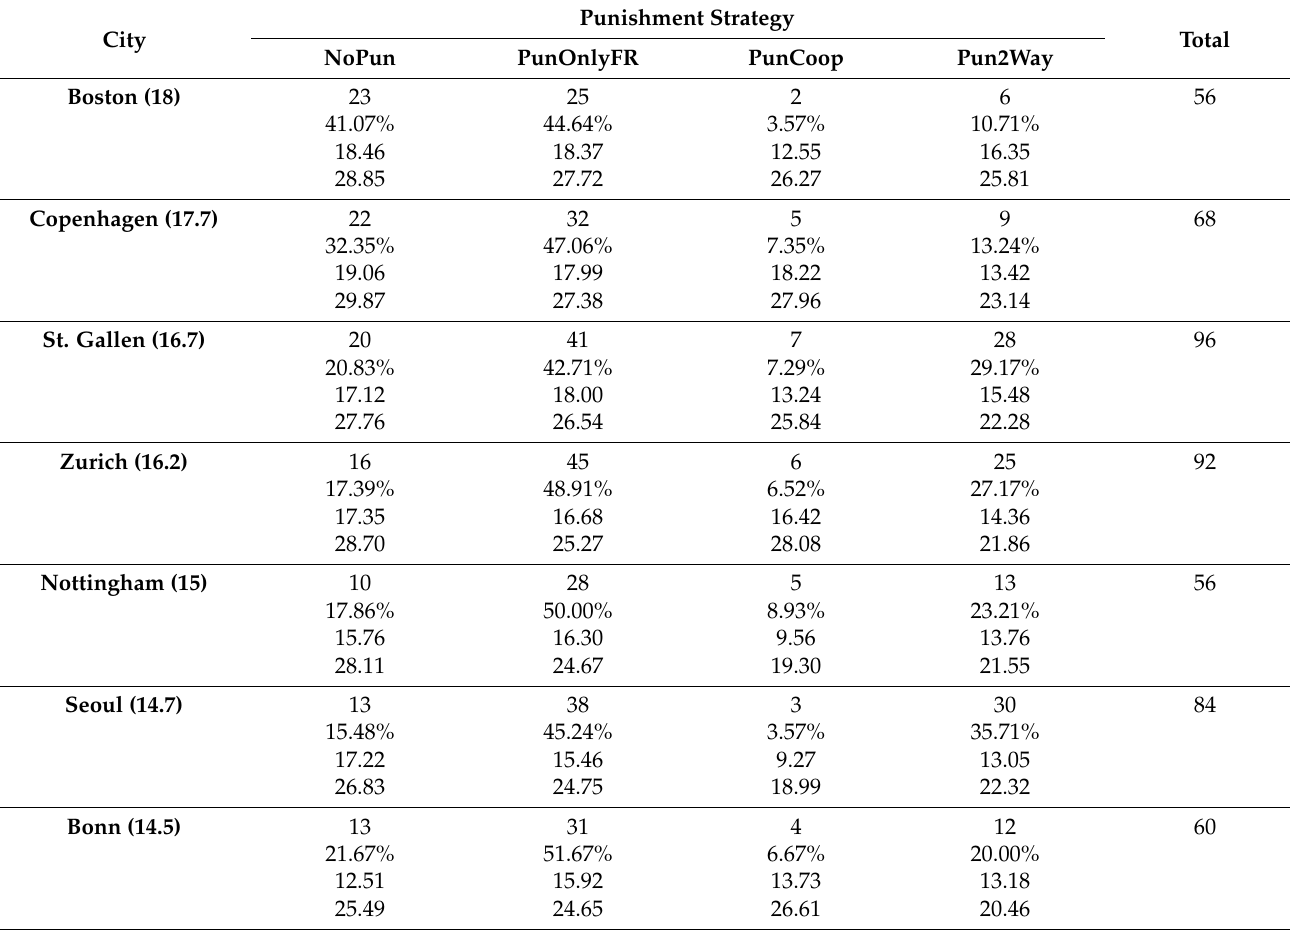
Table A1. Frequencies and relative frequencies of four punishment strategies across the sixteen participant pools investigated in Hermann et al.